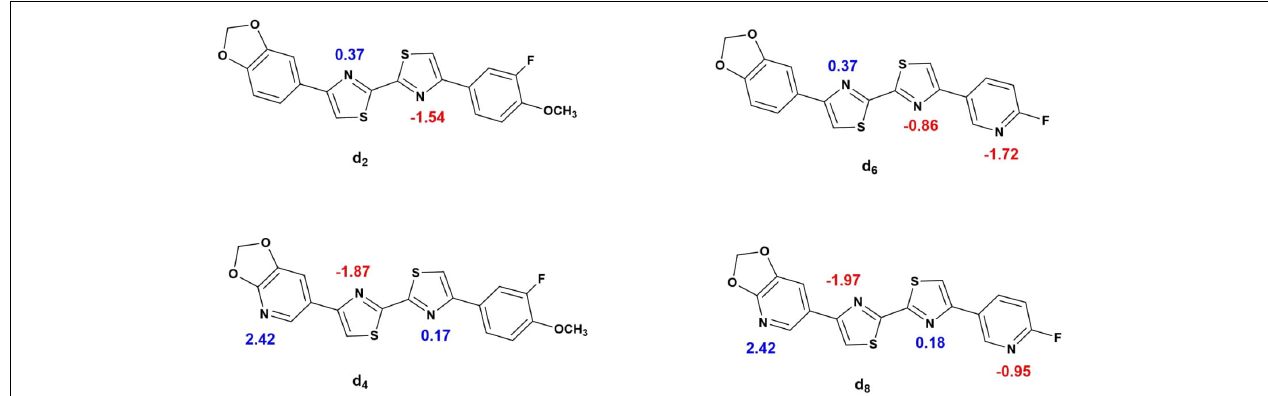
FIGURE 10 | pK a of the ionizable atoms in the d 2 , d 4 , d 6 , and d 8 (Chemicalize platform).